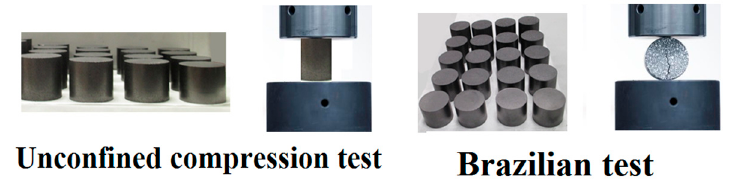
Figure 9. Destructive tests performed on green bodies.